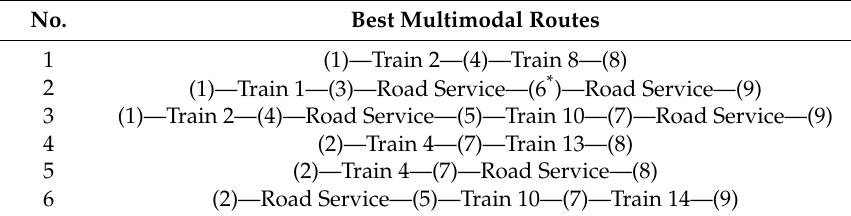
Table 4. Best multimodal routes under α = β = γ =